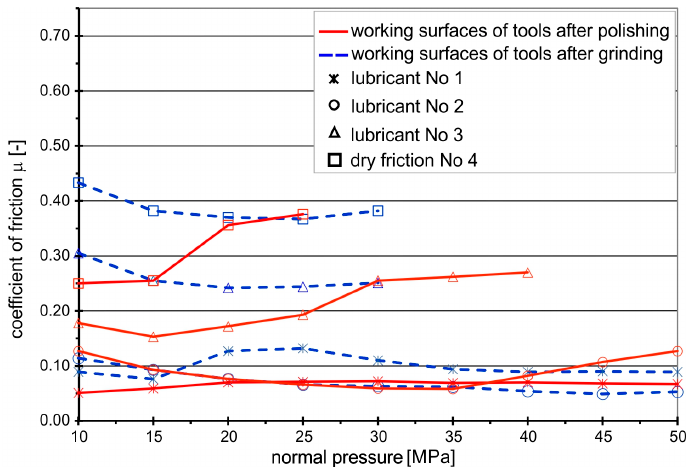
Figure 4. Coefficients of friction for frictional pair “titanium Grade 5–steel NC10”.